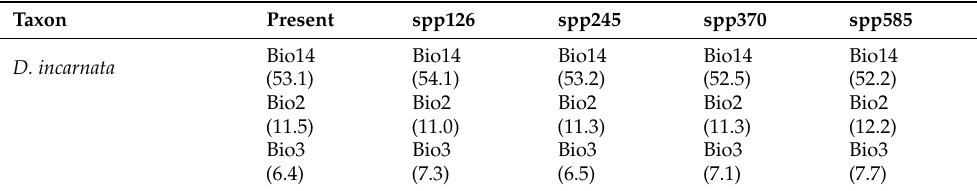
Table 3. Relative contributions of the bioclimatic variables in the Maxent model (top three values), normalized to percentage (in bracket).